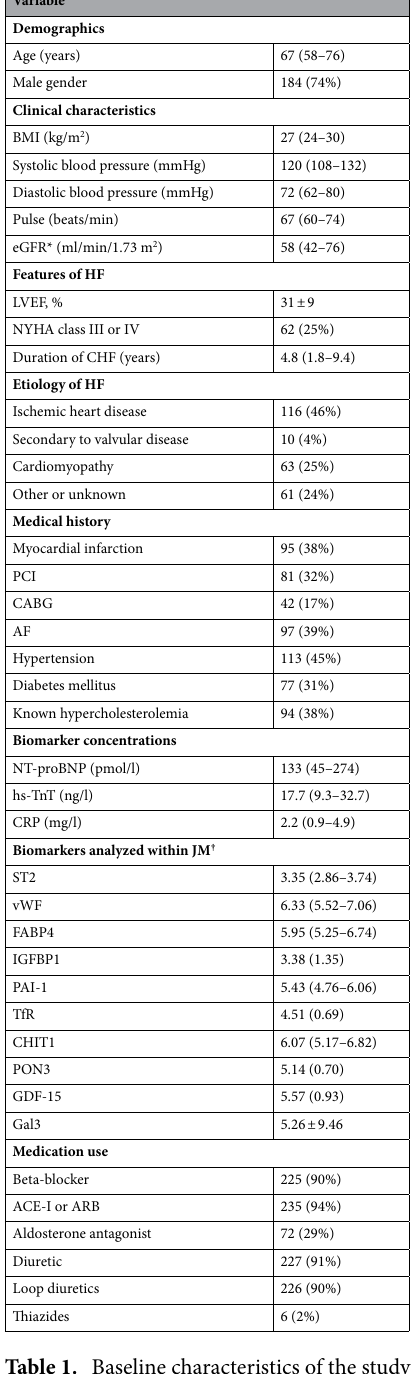
Table 1. Baseline characteristics of the study population (N = 250). Categorical variables are expressed as count (percentage). Values of continuous variables are expressed as mean ± standard deviation or as median (interquartile range) in case of skewed distribution. ACE-I Angiotensin-converting enzyme inhibitor, ARB Angiotensin II receptor blocker, CABG Coronary artery bypass grafting, CHIT1 Chitotriosidase-1, COPD